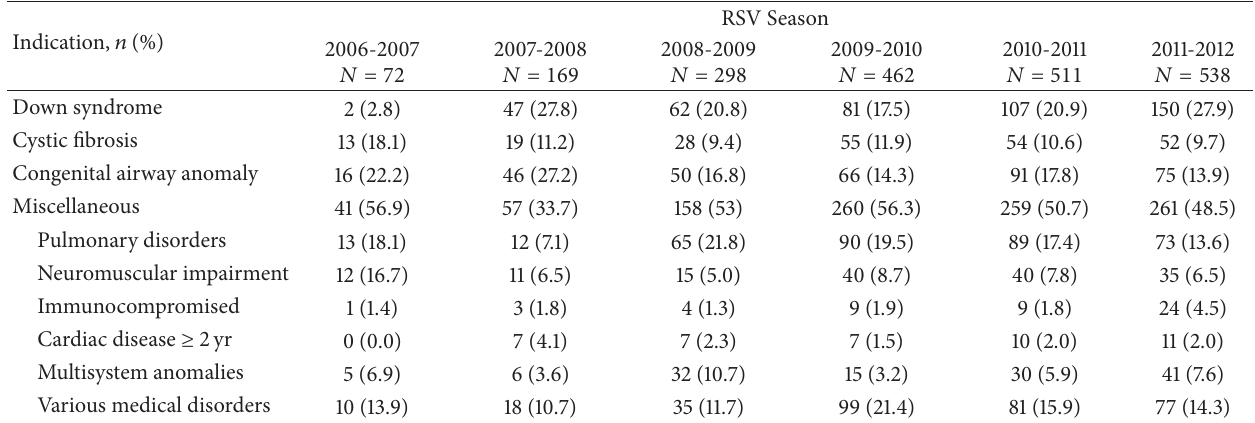
Table 2: Changing patient profiles in the subcategory “other” over 6 RSV seasons ∗